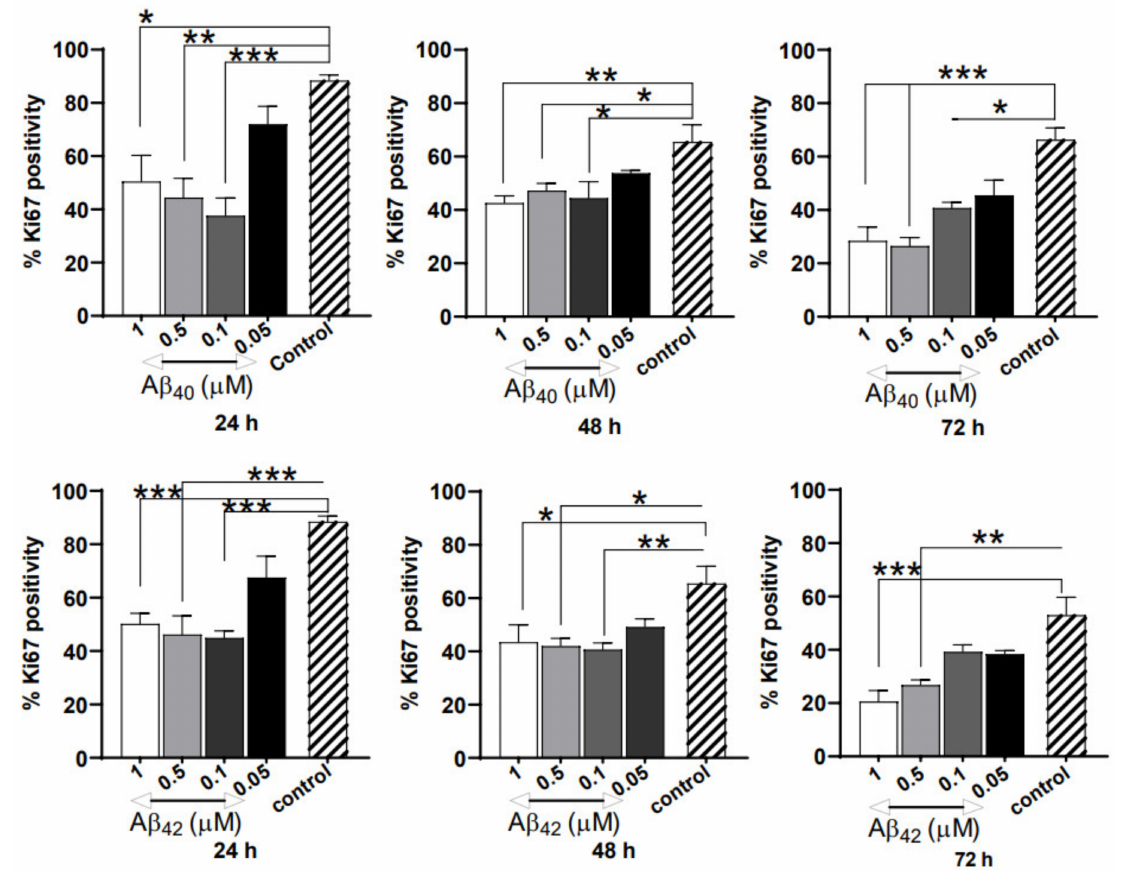
Figure 3. Dysregulation of NGC0211 proliferation by A β peptides. To study whether cellular proliferation is affected, NGC0211 cells (0.5 × 10 4 cells/well) were plated in a 16-well chamber slide and exposed to various A β 40/42 concentrations (1, 0.5, 0.1, 0.05 µ M) for different time points (24, 48, 72 h). Post exposure, cells were fixed and probed with mouse anti-human Ki67 antibody (1:100 dilution; clone MIB-1, DAKO, Glostrup, Denmark) followed by Alexa-488-anti mouse antibody (1:500 dilution, Invitrogen). Slides were mounted and imaged using an inverted laser scanning microscope. At least 3 images from individual samples were counted for Ki67 immunoreactivity and data is presented as Ki67-positive cells taken as a percentage of the total cell population (DAPI staining). Data are represented as mean ± S.E. ( n = 3). Statistical analysis using one-way ANOVA analyses with a Tukey’s multiple comparison test was performed to compare control and treated groups. * p < 0.05, ** p < 0.01, and *** p <